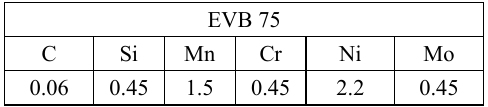
Table 3. Chemical composition of EVB 75 (%